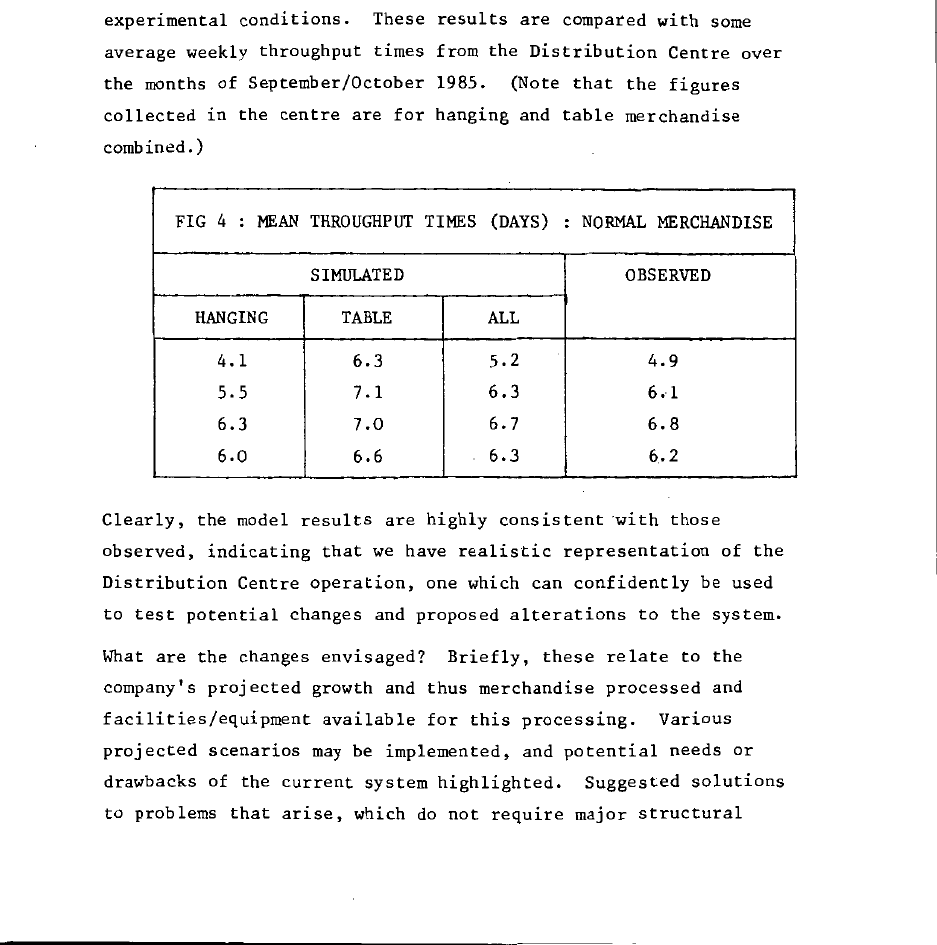
FIG 4 : MEAN THROUGHPUT TIMES (DAYS) : NORMAL MERCHANDISE SIMULATED